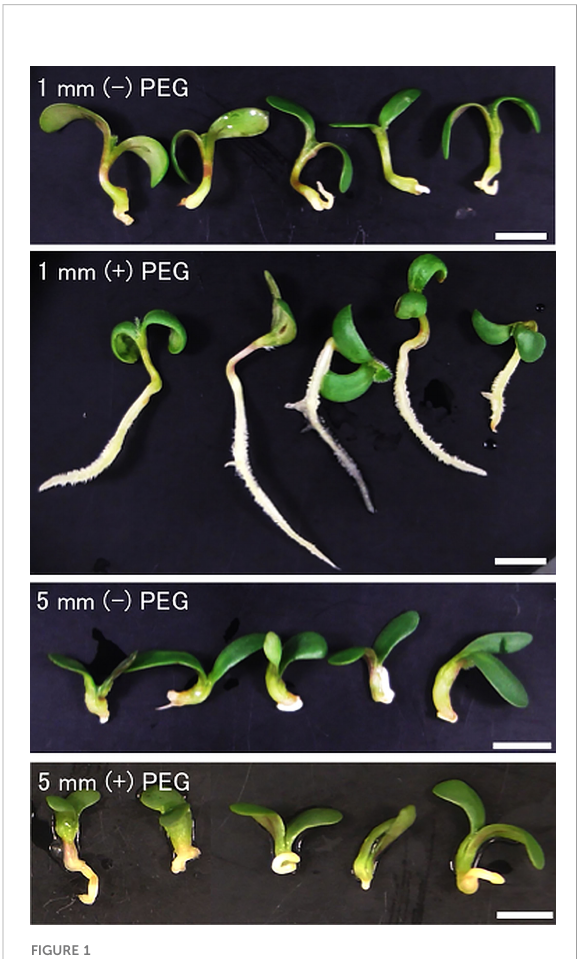
FIGURE 1 Inducibility of radicle desiccation tolerance by PEG treatment in germinating seeds of Medicago truncatula. Seeds upon germination were selected using radicle length. Germinating seeds displaying 1 mm or 5 mm radicles were either directly desiccated (R1, R5) or treated with a mild osmotic stress by PEG8000 (R1P, R5P), followed by desiccation treatment. After desiccation, differences in radicle growth were observed at 7 days after rehydration. White bar scales represent 5